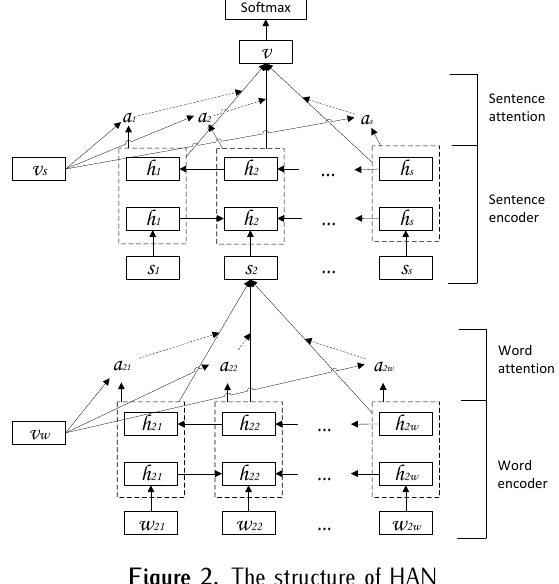
Figure 2. The structure of